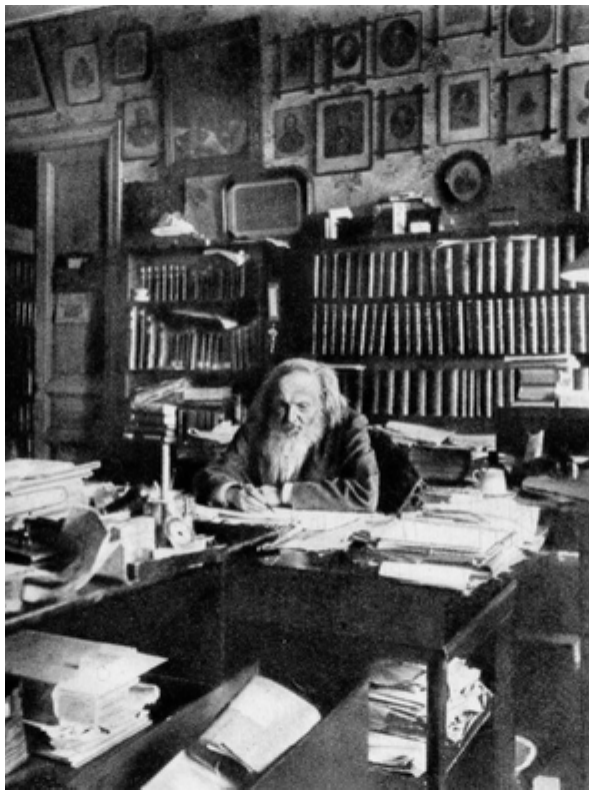
Figure 8. Mendeleev in his office: Russia’s new Central Board of Weights and Measures (permission of Museum and archives of Dmitri Mendeleev in St, Petersburg).